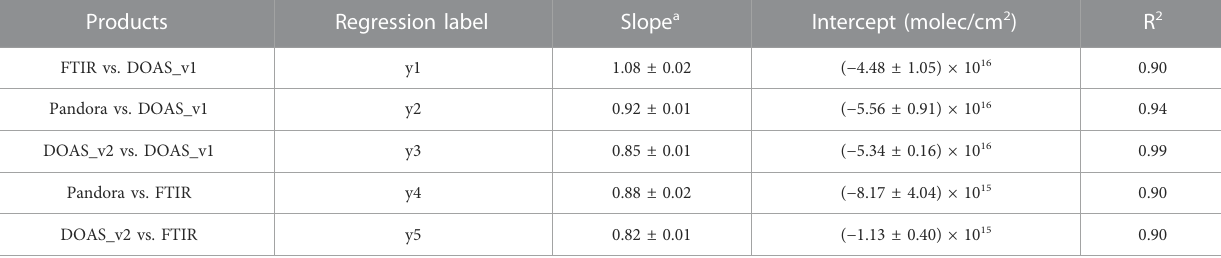
TABLE 3Linear fi tparameters obtained from the intercomparisonof theFTIR,S2000 DOAS andPandora SO 2 products. R 2 stands forthe determinationcoef fi